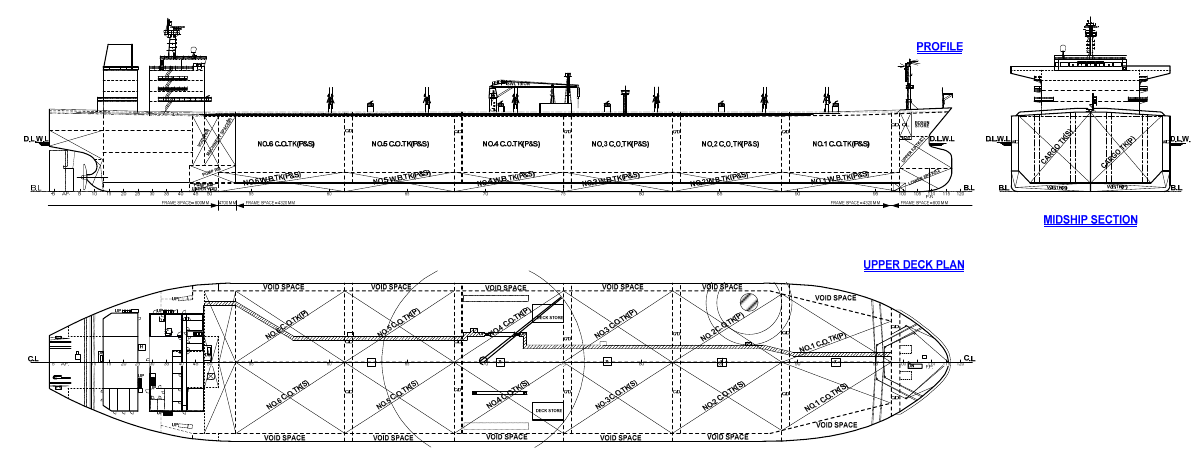
Figure 2. General arrangement of NGH